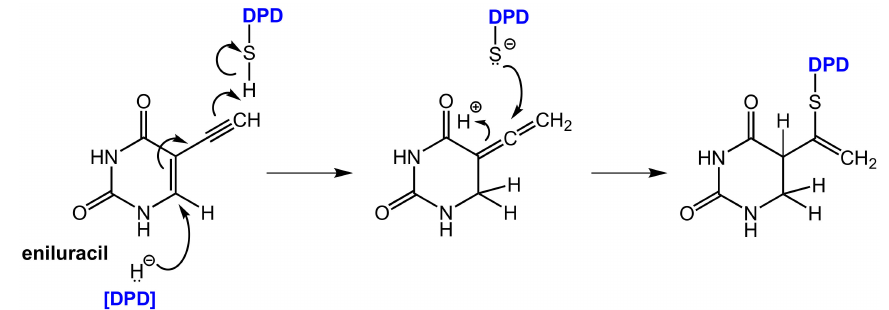
Figure 18. Covalent binding of eniluracil to DPD after reductive bioactivation by the target enzyme DPD itself [62].